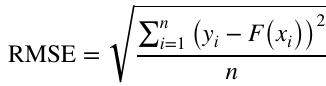
Fig. 10 GMDH method layout